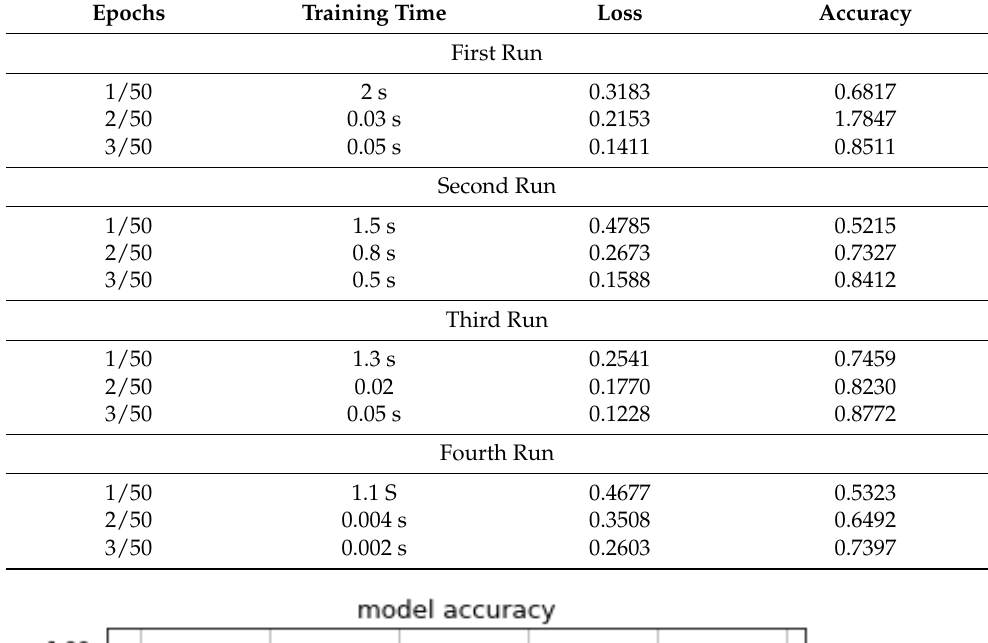
Table 2. Training time, loss, and accuracy of first three epochs of each run.